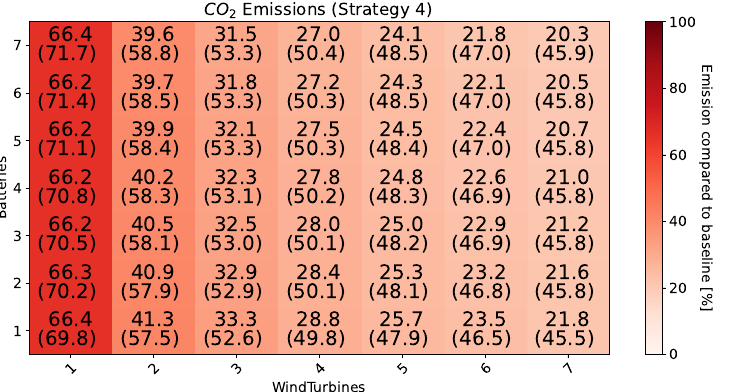
Figure 23. CO 2 emissions relative to baseline when the gas turbines can be turned off completely (0 emissions) or are kept idle with an emission rate of 0.5 kgs − 1 , shown in parentheses.